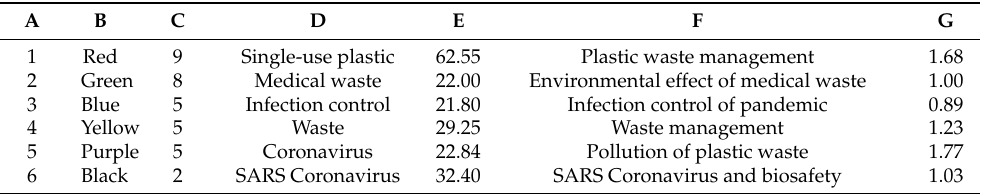
Figure 12. Overlay visualization, in terms of average citations, of network co-occurrences of authors’ keywords with a minimum of 5 occurrences. Table 5. Most-significant characteristics of clusters of influential keywords in the